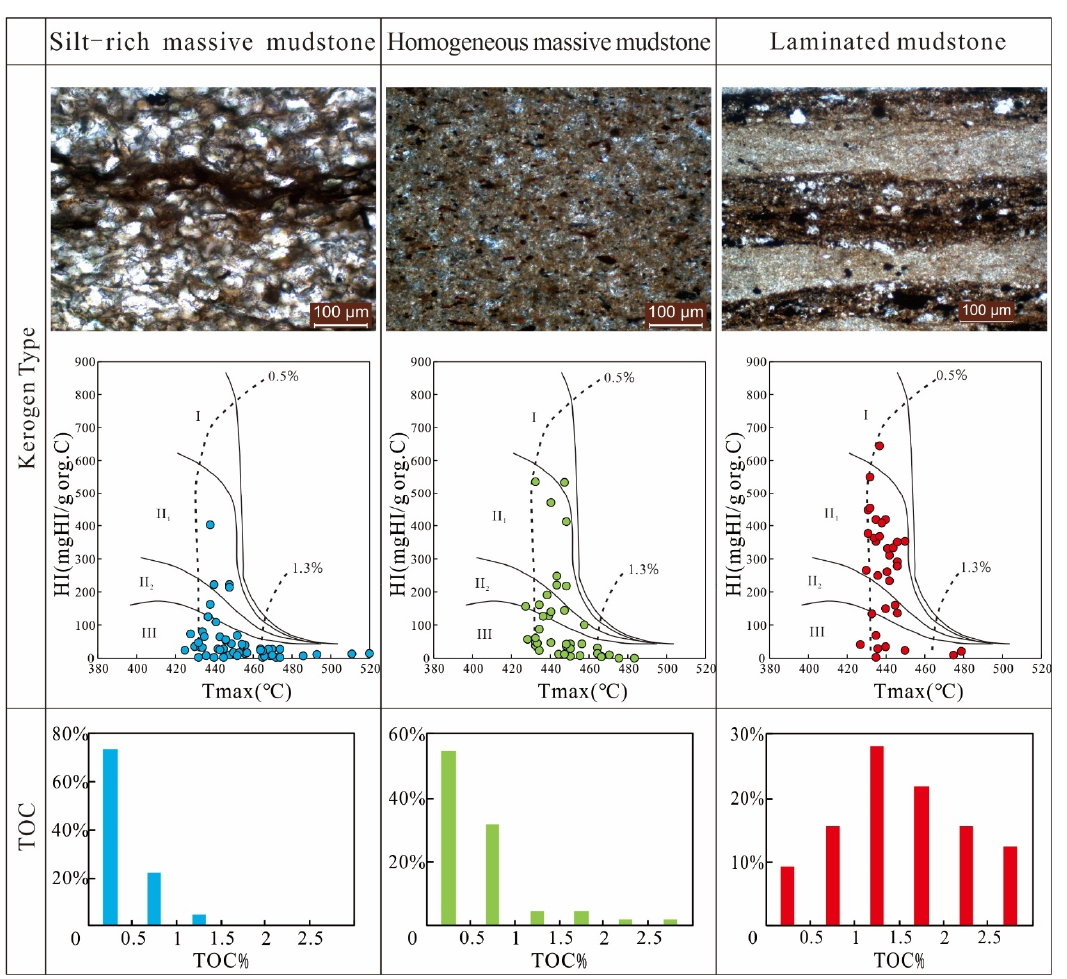
Figure 5. OM shape and type and TOC proportion of each